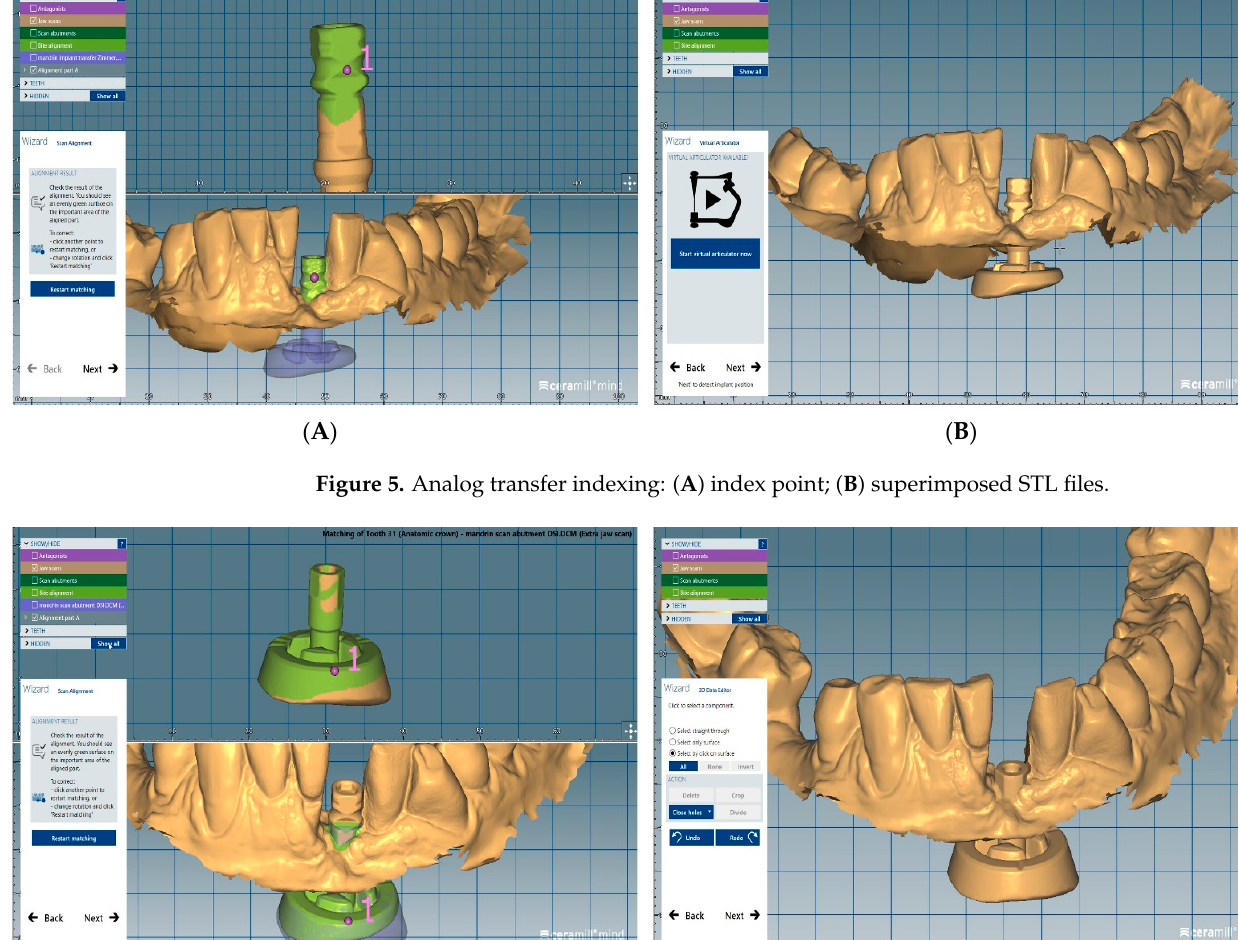
Figure 6. Scan abutment transfer indexing: ( A ) index point; ( B ) superimposed STL files.